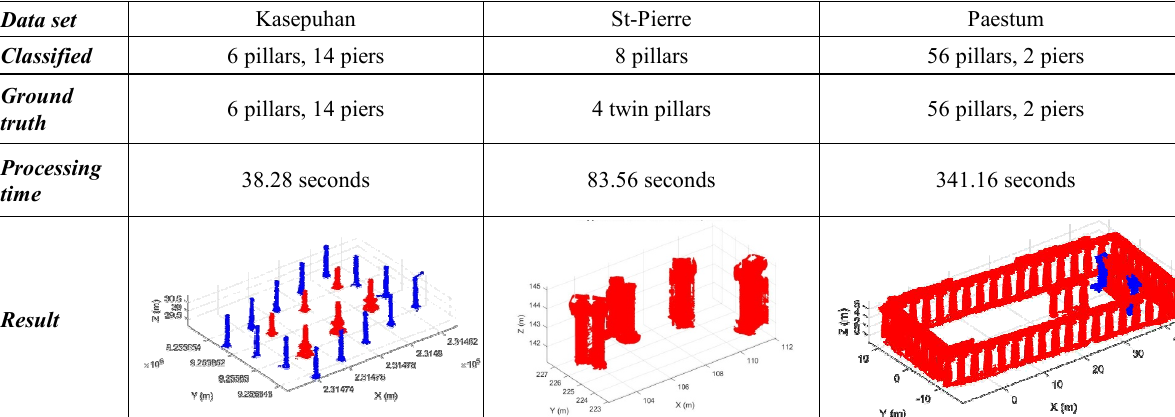
Table 3. Comparison of the results of the classification part of the algorithm on the three data sets. Red denotes the column class while blue the pier class. Note that processing time is for both the segmentation and classification steps, which were integrated into one